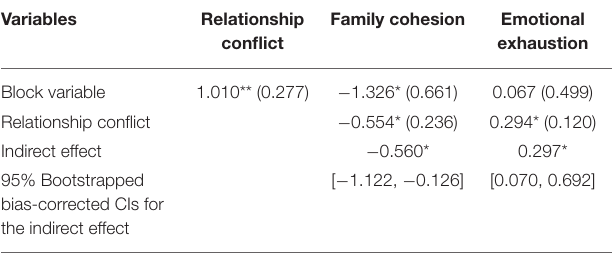
TABLE 4 | Results from tests of direct and indirect effects of congruence/incongruence in WFE on relationship conflict, family cohesion, and emotional